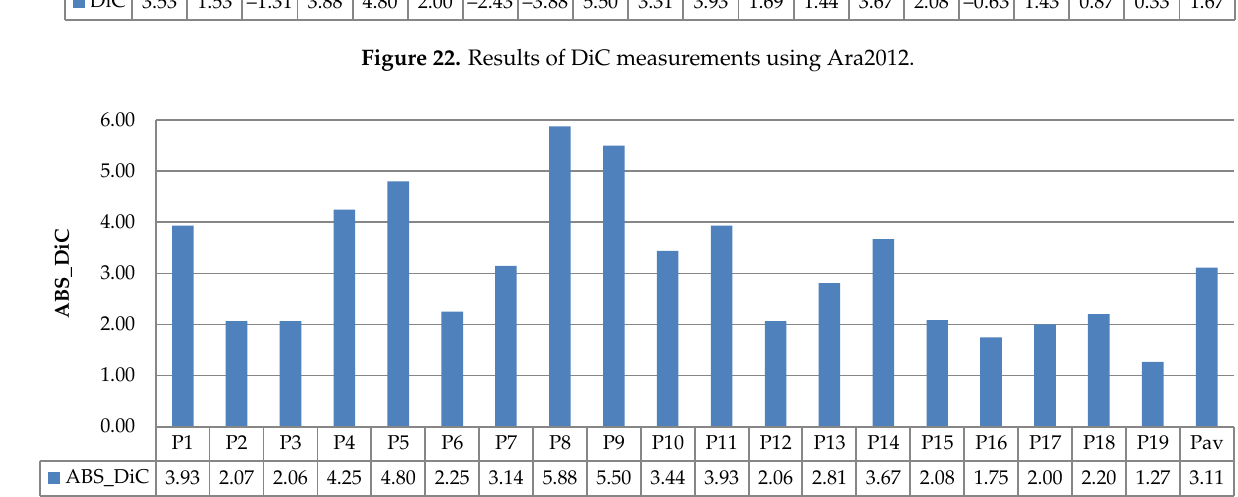
Figure 23. Results of ABS_DiC measurements using Ara2012.